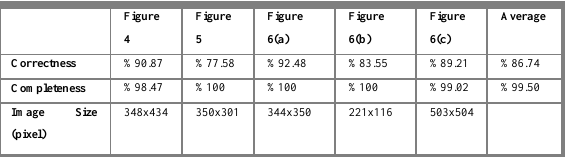
Table 1: Evaluation of results for Salient Roads Using Ribbon